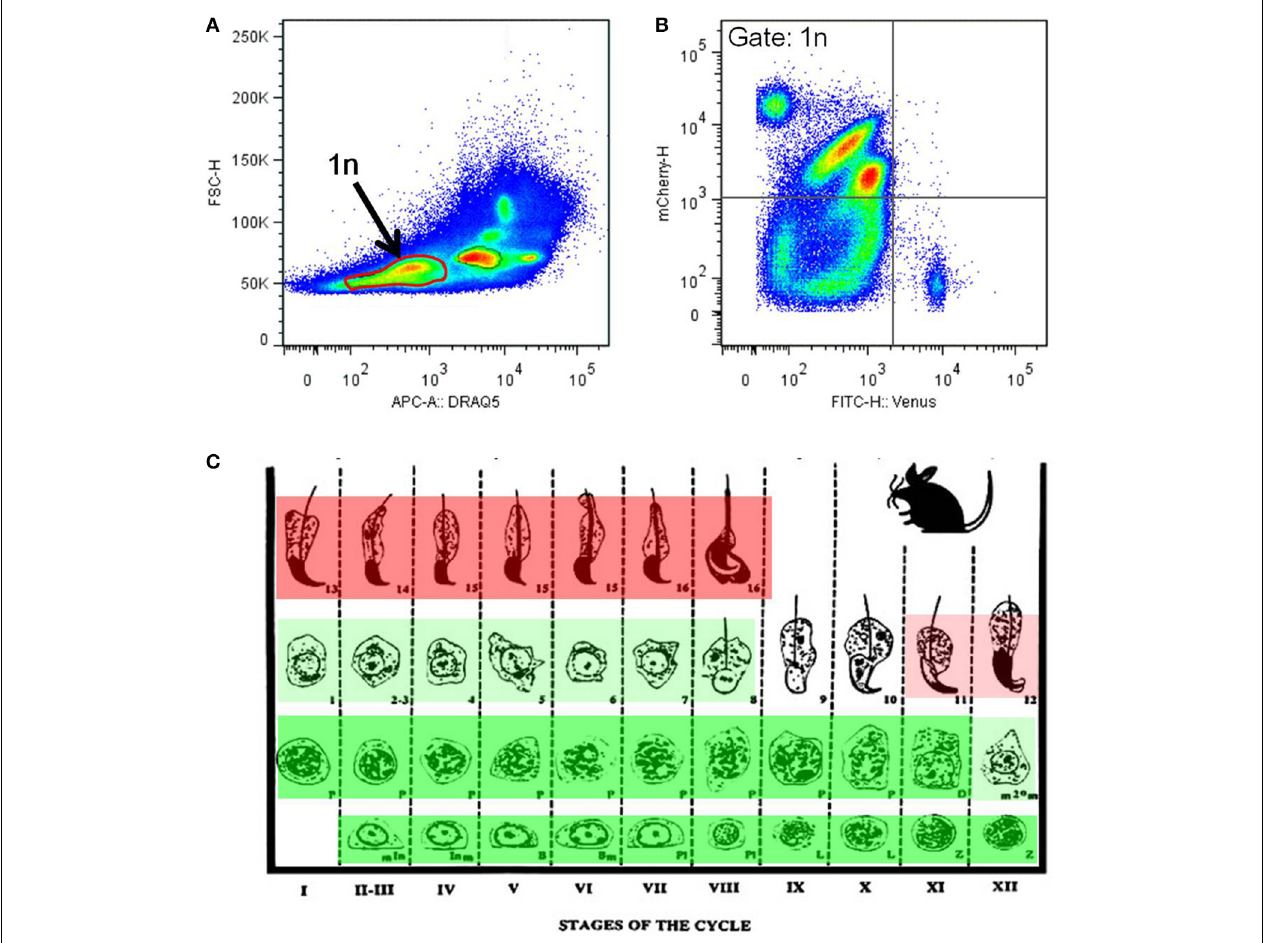
FIGURE 4 | Flow cytometry analysis of the H4V/H33C double Tg testes. (A) Separation of testicular cells by the DNA contents. Approximately 30% of cells with low DRAQ5 fluorescence are assessed as post-meiotic haploid cells indicated as 1n. (B) Expression of Venus and mCherry in haploid cells gated in